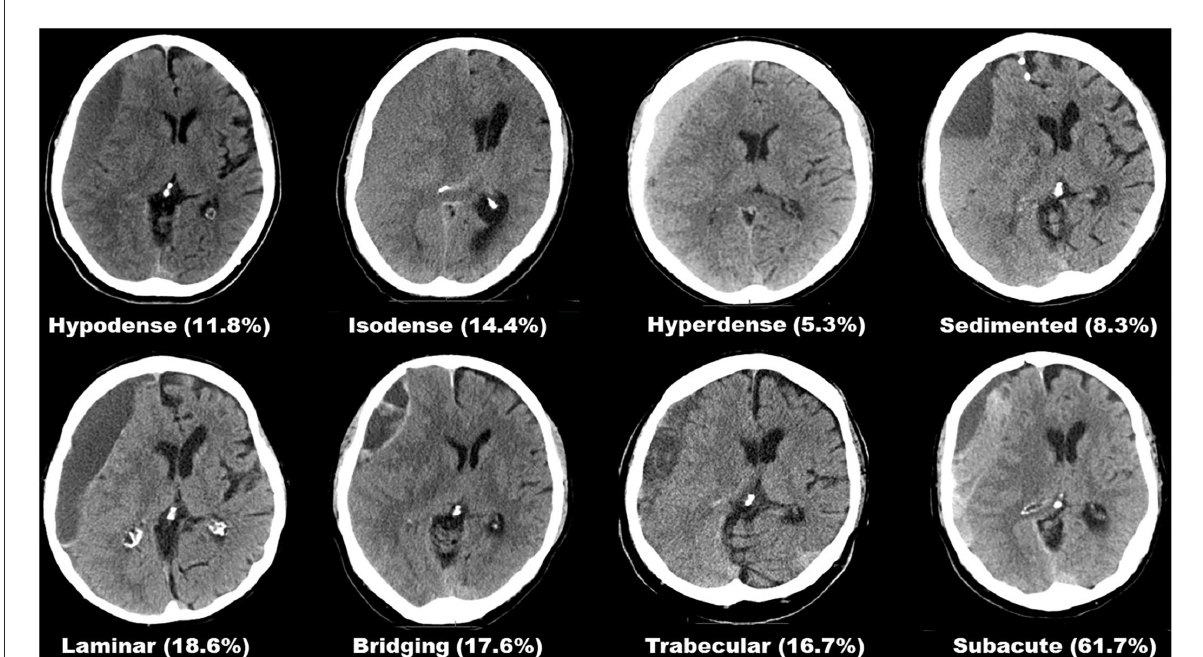
FIGURE1 Overview of all eight hematoma subtypes based on internal architecture as seen in CT imaging and their respective rates of suspected seizure.